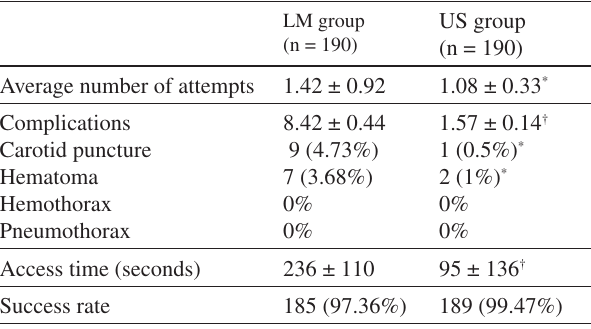
Table 2 - Comparison of ultrasound and landmark techniques in internal jugular vein